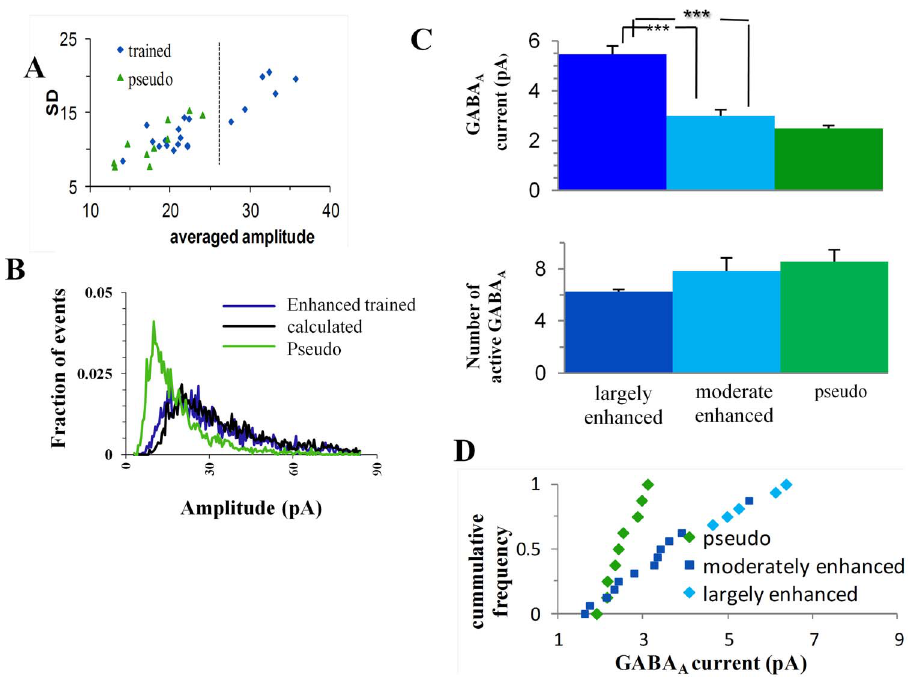
Figure 6. In a sub-group of cells from trained rats, amplitudes of all inhibitory miniature events are doubled. A. Each cell was plotted as a function of its averaged event amplitude and standard deviation. Few cells from trained-group had exceptionally large averaged amplitudes and Standard-deviations. Using hierarchical clustering analysis the cells were divided to two groups (separated by the dotted line; the same division was obtained for all the methods that were implemented). B. The distribution curve describing the greatly-enhanced trained neurons can be constructed from the distribution curve describing the pseudo-trained neurons. The expected curve (black) calculated from pseudo events (green) overlaps the averaged distribution curve of the greatly-enhanced-trained group (blue). (r=0.85, only amplitudes . 13pA were used, since at lower amplitudes, multiplication factors bigger than two requires unavailable data in amplitudes , 6pA, see Methods) C. The averaged GABA A single channel conductance in the greatly-enhanced-trained-group was doubled compared with the pseudo-trained group, and is 82% bigger than in the moderately-enhanced-trained group. Values represent mean 6 SE, (***, p , 0.001). The number of active GABA A channels does not differ between groups. D. The greatly enhanced group shows distinct values of averaged GABA A R conductance as compared with the moderately enhanced